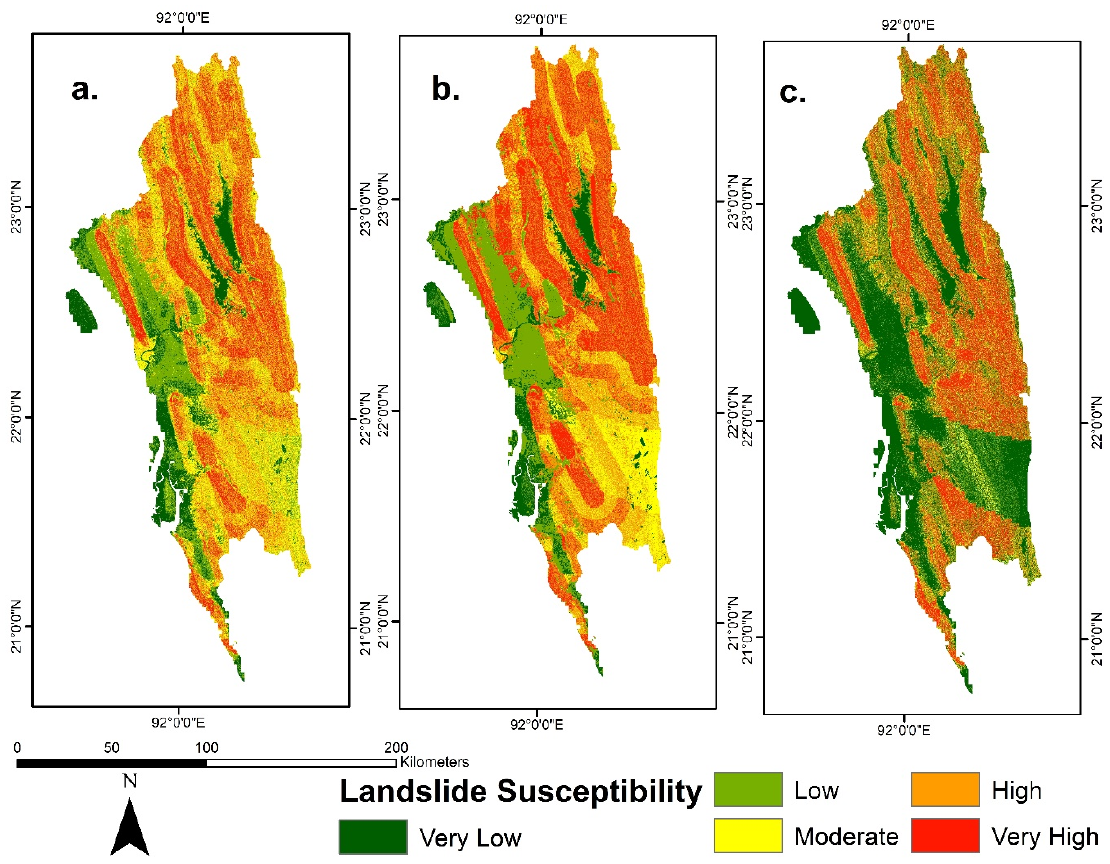
Figure 7. Landslide susceptibility maps of the CHA, Bangladesh. ( a ) FR; ( b ) FR_AHP; ( c ) FR_LR.